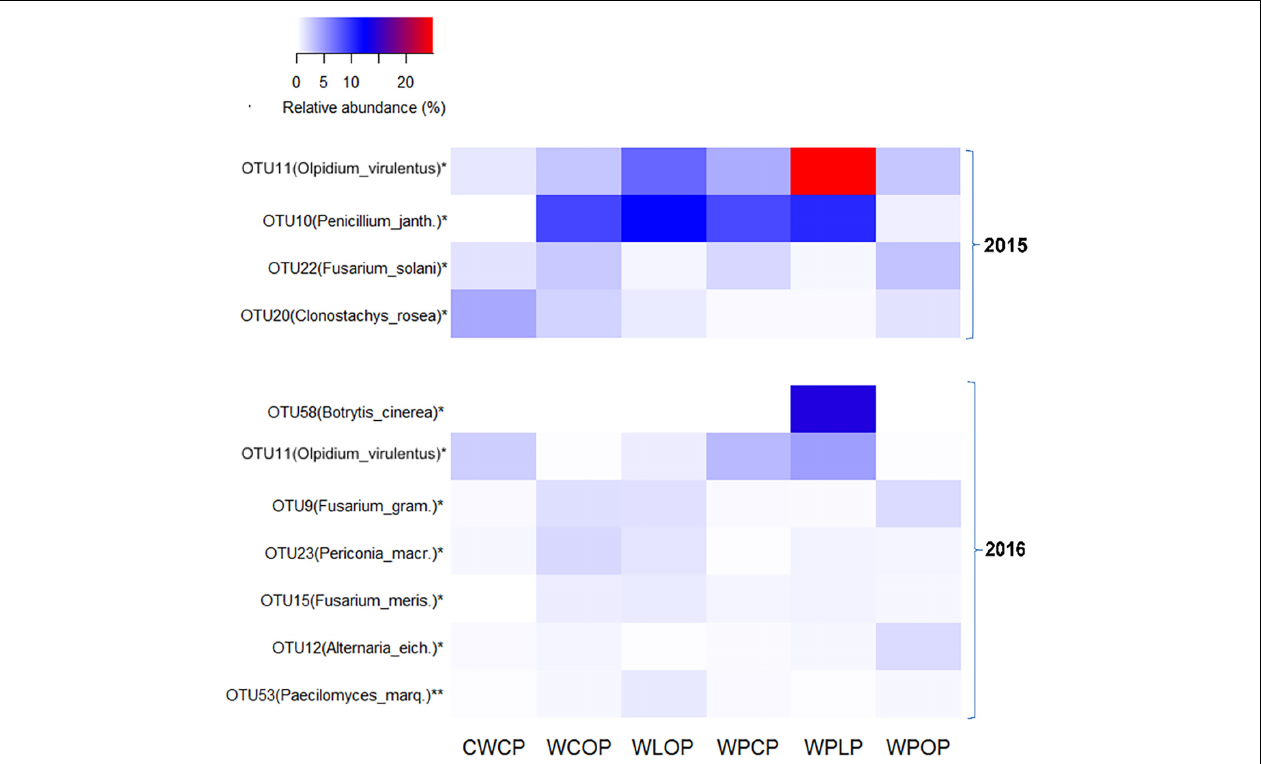
FIGURE 7 | Heatmap showing the most abundant fungal OTUs ( > 0.2% of total reads) in pea rhizosphere that significantly influenced by cropping system in both 2015 and 2016. OTUs with an ∗ indicates a significant difference in relative abundance among the rotation sequences at ∗ P < 0.05 and ∗∗ P <